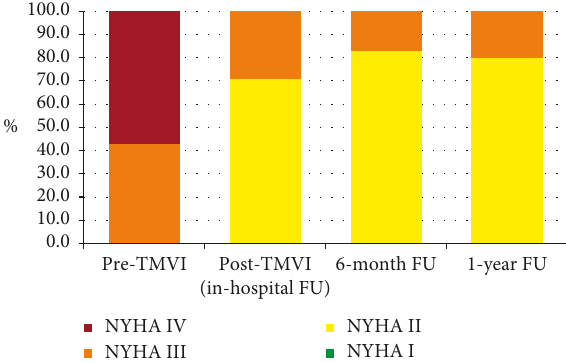
Figure 6: Comparison of NYHA functional classes before TMVI and at in-hospital, 6-month, and 1-year